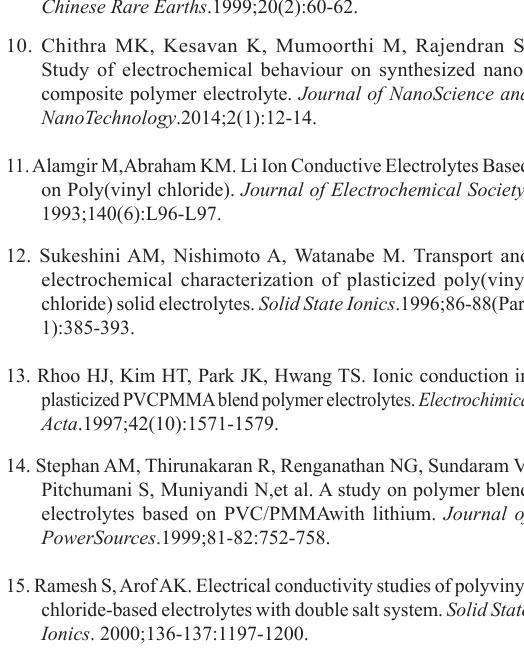
decreasing trend with increasing dopant concentration.